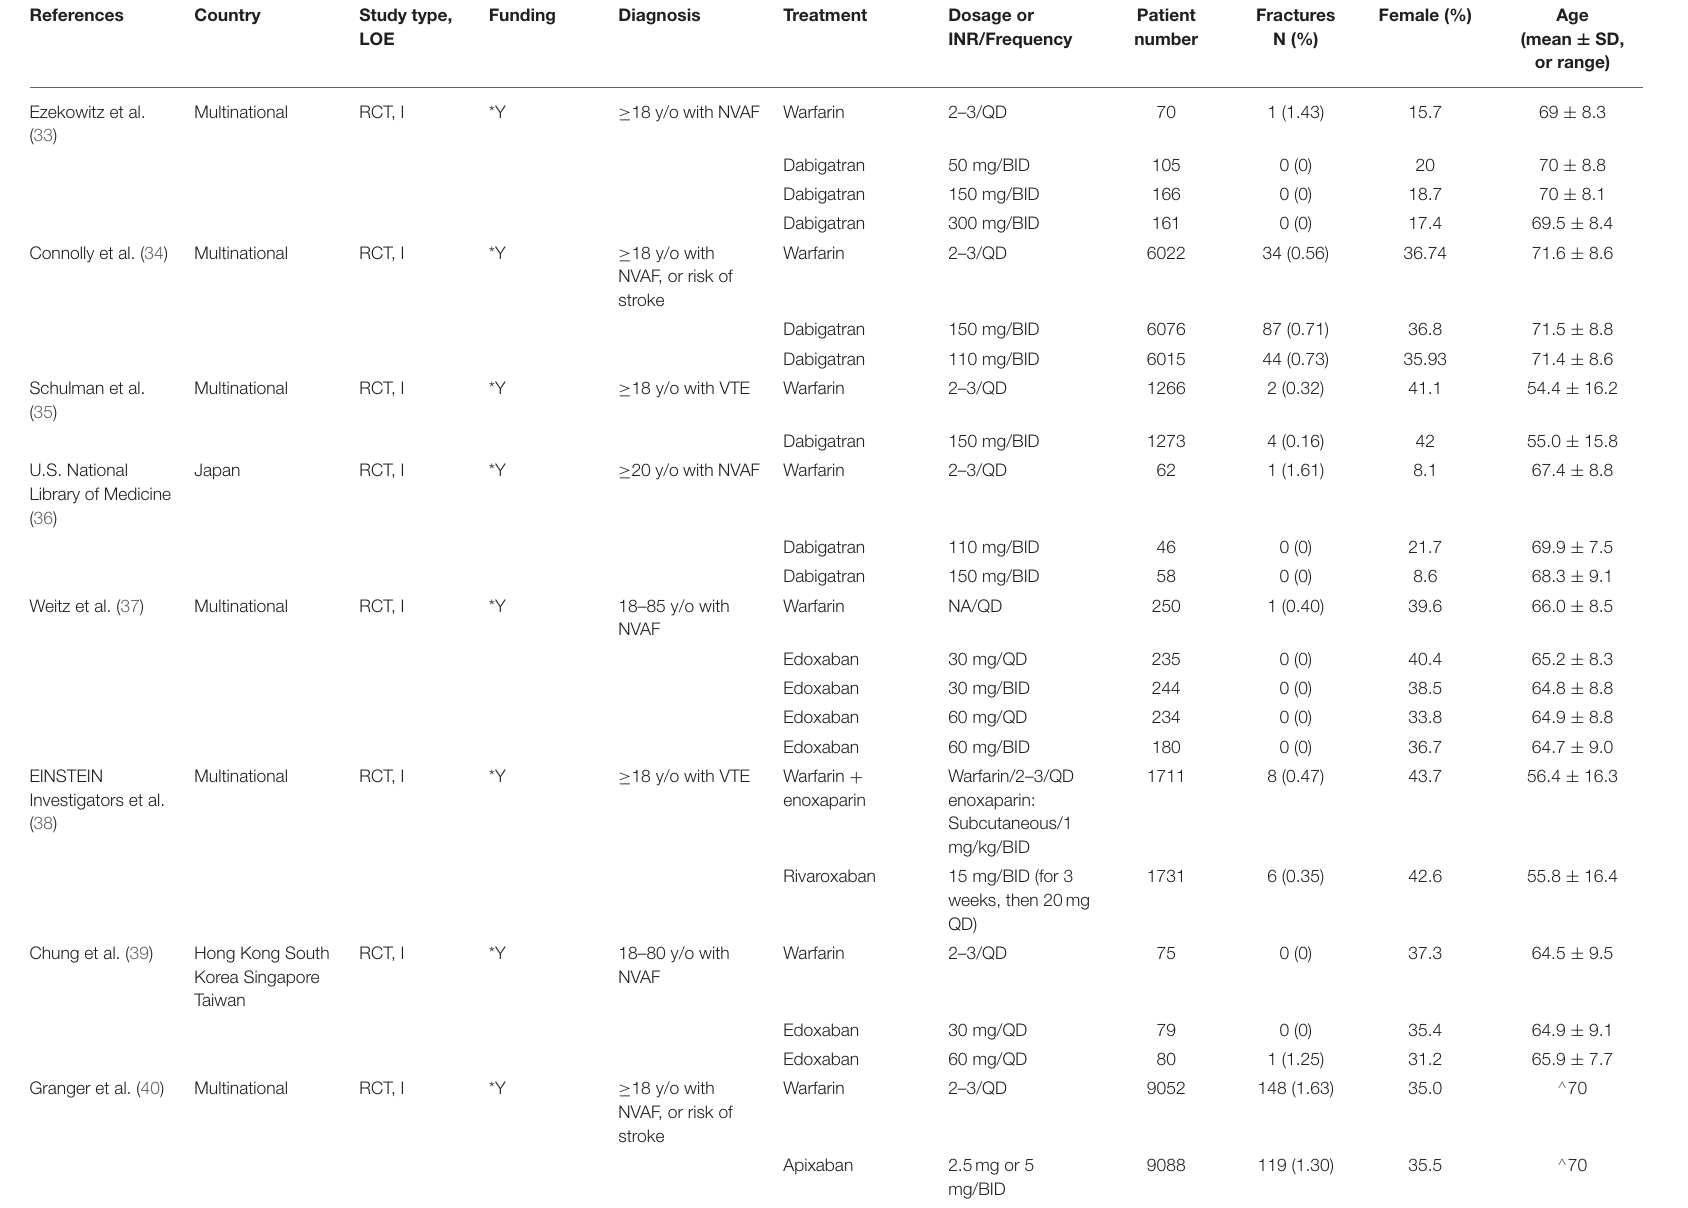
TABLE 1 | Characteristics of included